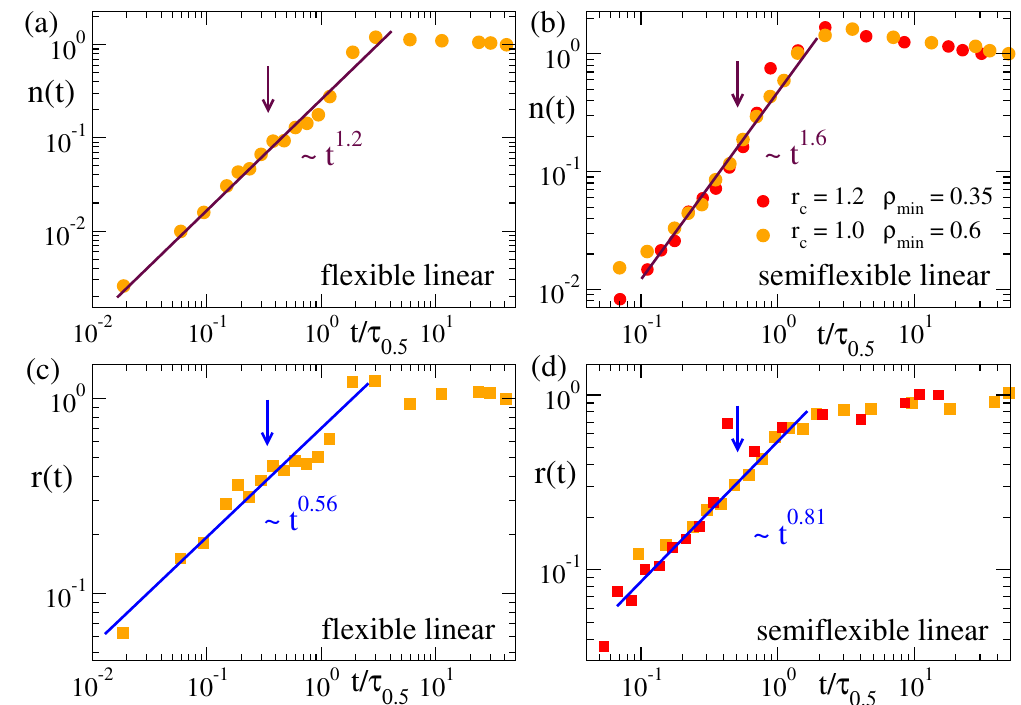
Figure 7. Normalized population ( a , b ) and radius ( c , d ) of the clusters in the density field representation of the flexible ( a , c ) and semiflexible linear chain ( b , d ). Data correspond to a solvent quality parameter φ = 1.2. Values ( r c = 1.0, ρ min = 0.6) and ( r c = 1.2, ρ min = 0.35) are used to construct the density field. The arrows indicate the time scale for which N clus ( t ) = N ∗ ≈ 400. Times are rescaled by τ 0.5 as defined in Figure